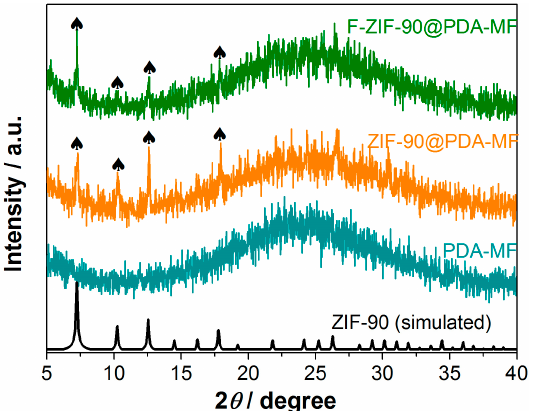
Figure 3. X-ray di ff raction pa tt erns for PDA-MF, ZIF-90@PDA-MF, and F-ZIF-90@PDA-MF compo- Figure 3. X-ray diffraction patterns for PDA-MF, ZIF-90@PDA-MF, and F-ZIF-90@PDA-MF composite site sponges. The black symbol ( ♠ ) indicates the main characteristic di ff raction peaks of ZIF-90. sponges. The black symbol ( ♠ ) indicates the main characteristic diffraction peaks of